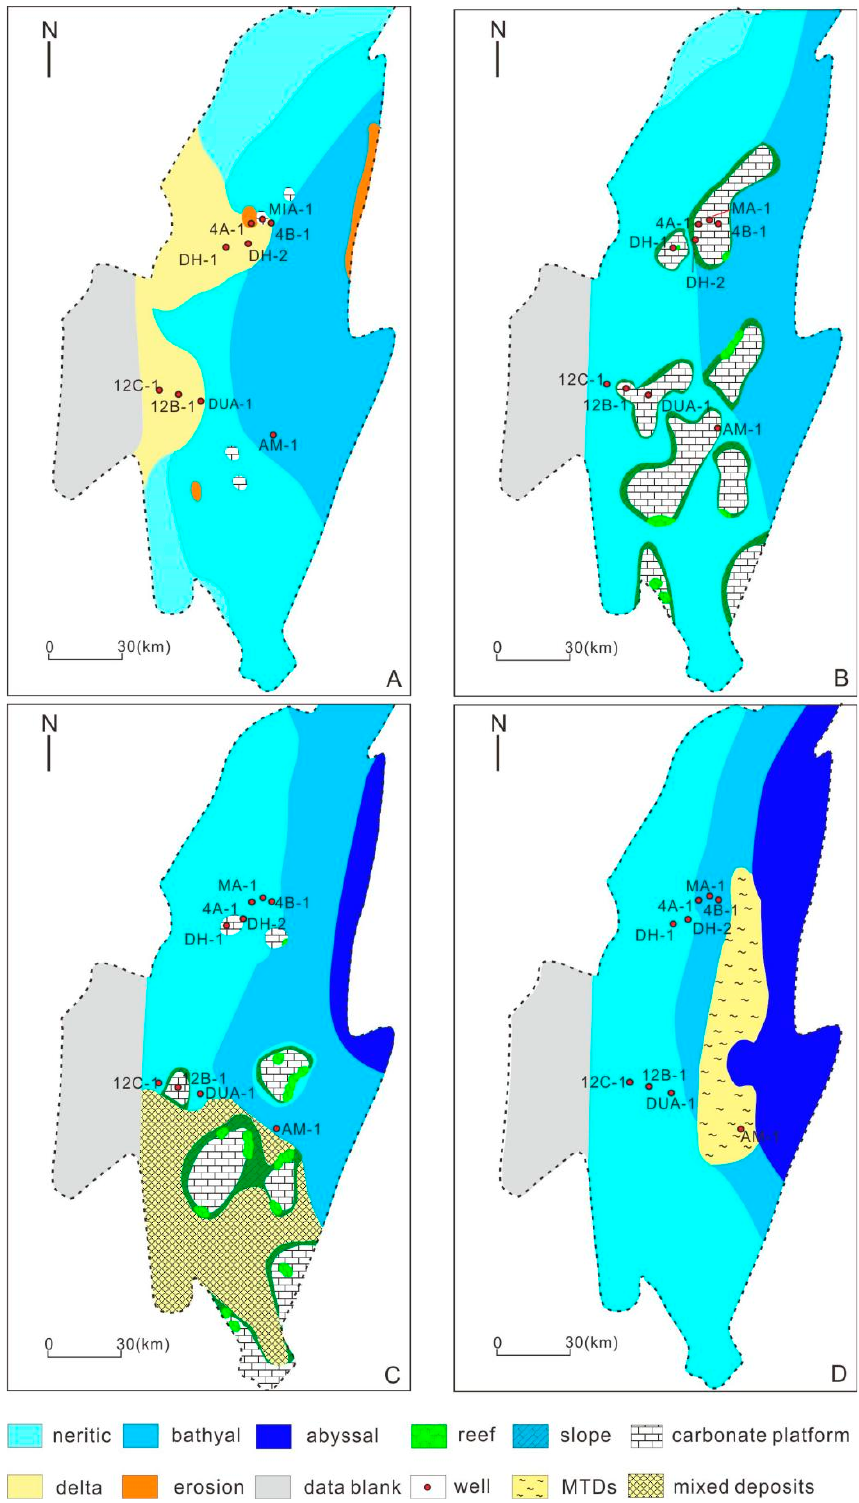
Figure 10. The temporal and spatial distribution map of RCPs in Wan’an Basin. ( A ): the initial phase; ( B ): the prosperous phase; ( C ): the recession phase; ( D ): the submerged phase.